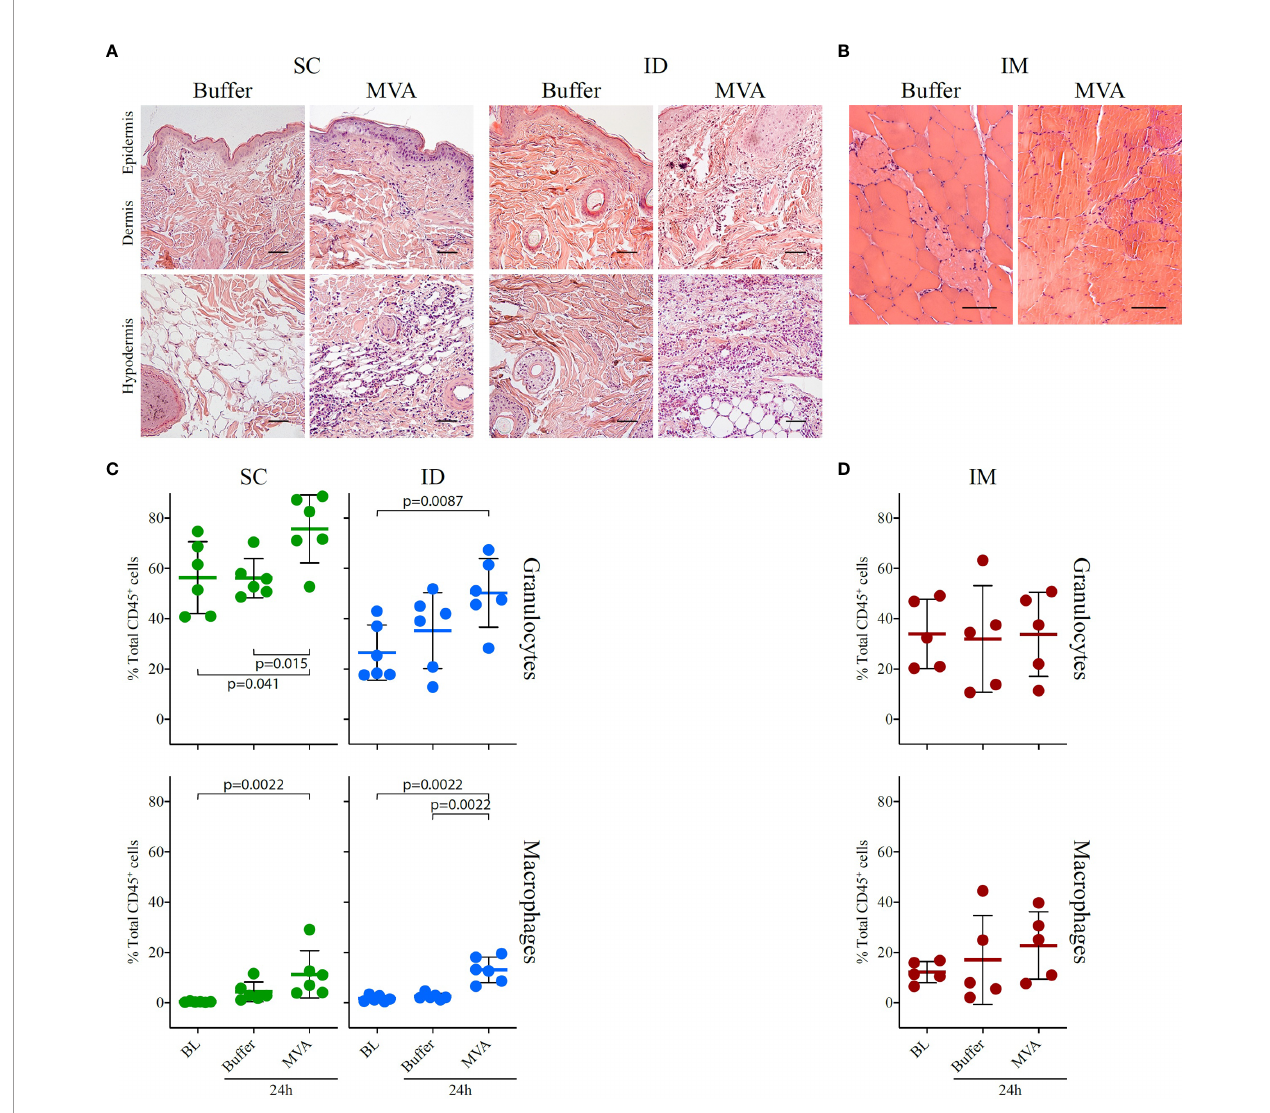
FIGURE 7 | Local in fl ammatory response 24 h after MVA immunization by the SC or ID route. (A) HE staining of the injection site (skin + subcutaneous tissue) and draining inguinal lymph node, showing transversal sections of paraf fi n-embedded tissue cassettes 24 h after ID or SC injection of buffer or rMVA. The scale bar is equal to 50 µm. One representative experiment of two is shown. A scatter plot representation of local cellular movement to the site of injection at baseline and following injection with buffer or MVA by the SC or ID route is shown at the bottom. (B) HE staining of muscle, showing transversal sections of paraf fi n-embedded tissue cassettes at baseline and 24 h after injection with PBS and 24 h after MVA immunization. The scale bar is equal to 50 µm. On the bottom, scatter plot representation of local cellular movement to the site of injection at baseline and after injection with buffer or MVA after (C) SC or ID route and (D) IM route. Each dot represents one biological sample (n = 6 for the ID and SC groups and n = 5 for the IM group). Values correspond to the percentage of cells among CD45 + cells conforming to the gating strategy in Figure S5A for the SC and ID group and Figure S5B for the IM group. Statistical analysis consisted of a Mann-Whitney test